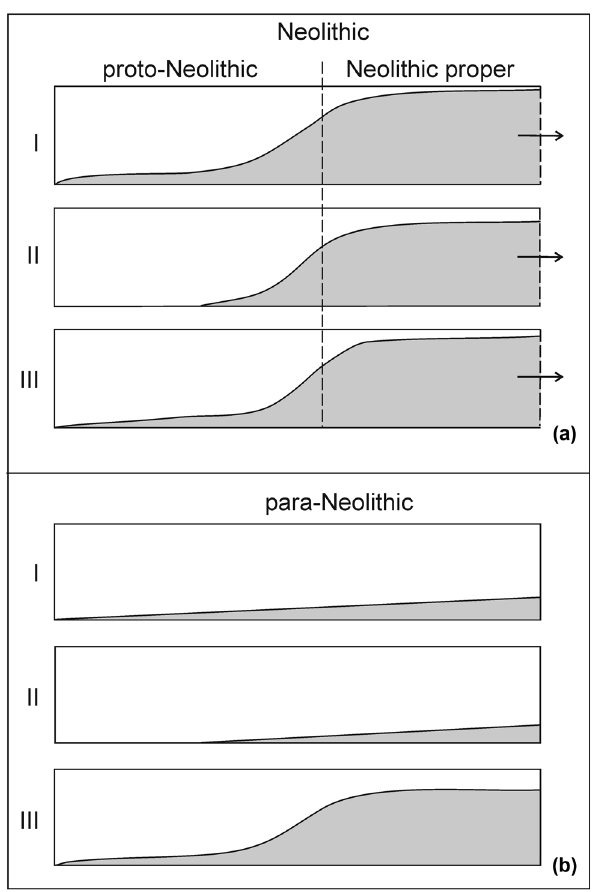
Figure 1: A schematic representation of the idea of the Neolithic proposed in the paper. Perhaps, this scheme looks a bit childish, but on the other hand, its simplicity contributes ( hopefully ) to the correct perception of this idea. ( a ) The Neolithic proper and phenomena of a preliminary/precursory nature; ( b ) alternative phenomena to the Neolithic, in the context of which some elements of the Neolithic package are present; ( I ) the participation and signi fi cance of meta - material socio - organisa - tional, ideological, mental and – consequently – meaning structures; ( II ) the participation and signi fi cance of agriculture in the food economy, ( III ) the participation and signi fi cance of pottery in the container sector and container - related symbols. Of course, agriculture and pottery were only used as examples. There are more other material indicators of the